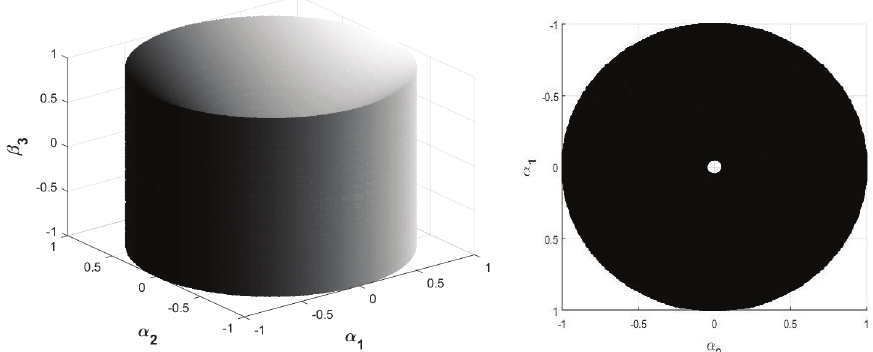
Figure A4. The left image shows a typical 3 D submanifold of the ˘ D family that has a topology. The right figure shows the projection of this submanifold on the plane ( α 1 , α 2 ) . Recall that the projections of the submanifold on the plane ( α 2 , β 3 ) and ( α 1 , β 3 ) do not contain